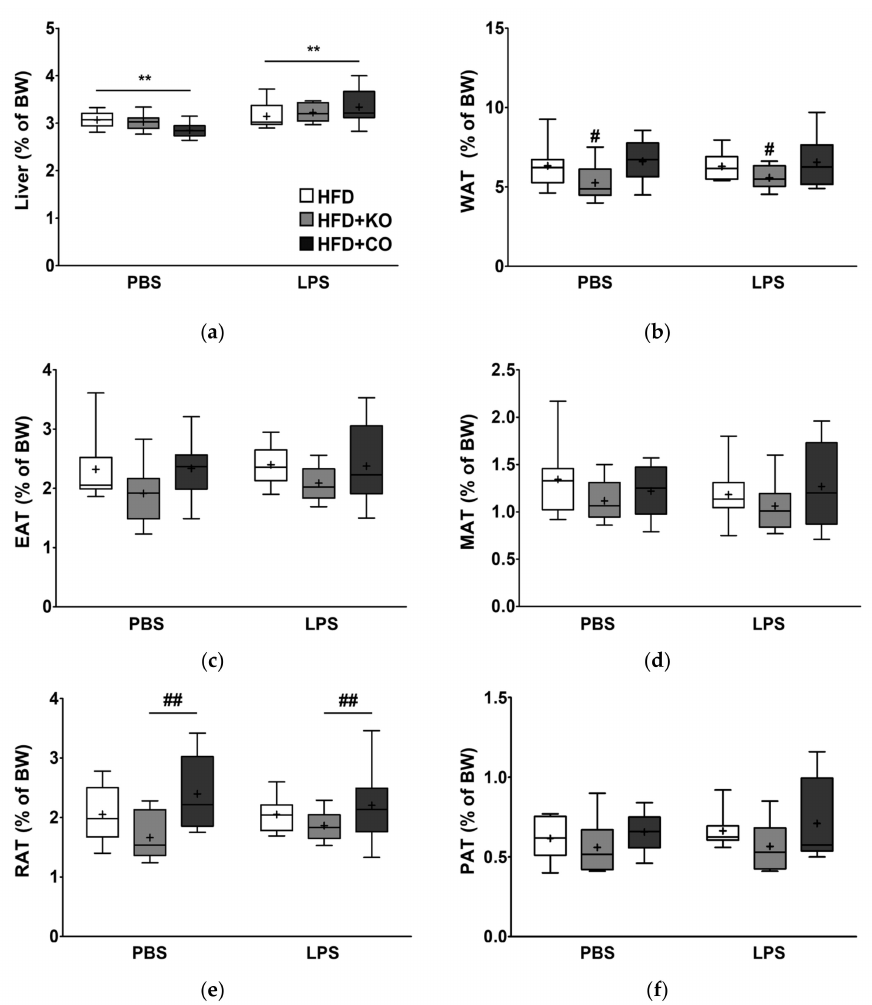
Figure 2. Effects of partial replacement of dietary fat with krill oil or coconut oil on hepatomegaly and adiposity in rats after the LPS challenge. Sprague Dawley rats were fed either a high-fat diet (HFD), HFD partially replaced with krill oil (HFD + KO), or coconut oil (HFD + CO) for 10 weeks, and then treated with PBS or LPS (1 mg/kg) for 24 h. ( a ) Liver, ( b ) total white adipose tissue (WAT), ( c ) epididy- mal white adipose tissue (EAT), ( d ) mesenteric white adipose tissue (MAT), ( e ) retroperitoneal white adipose tissue (RAT), and ( f ) perirenal white adipose tissue (PAT) weights were measured. Values are displayed as box-and-whisker plots; n = 8 per individual group. Data were analyzed by two-way ANOVA followed by Tukey’s multiple comparisons test to determine the interactions or the main effects (diet and LPS stimulation). Asterisk indicates a significant main effect for LPS (** p < 0.01). Pound indicates a significant main effect for diet ( # p < 0.05, ## p < 0.01). The mean values are indicated by “+” signs. HFD, high-fat diet; HFD + KO, high-fat diet + krill oil; HFD + CO, high-fat diet + coconut oil; PBS, phosphate-buffered saline; LPS, lipopolysaccharide; BW, body